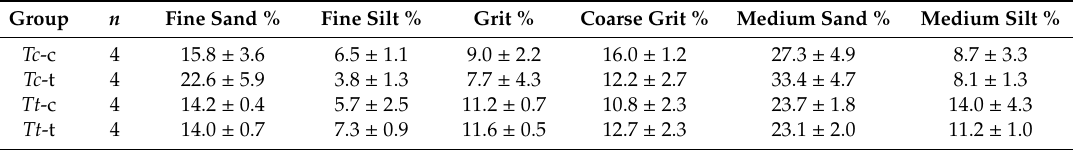
Table 1. Soil characteristics for both the control and drought treatment groups of T. cordata and T. tomentosa.